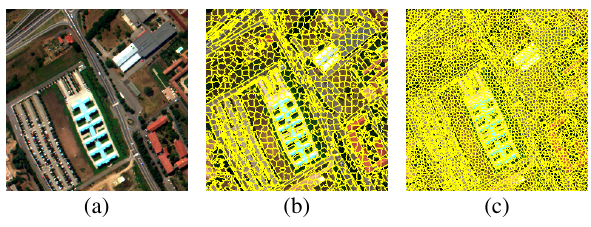
Figure 3. Visualization of the Pavia University segmentation. (a) depicts a RGB image section, (b) illustrates the segmentation result with 1% and (c) with 4% of the total number of pixels.